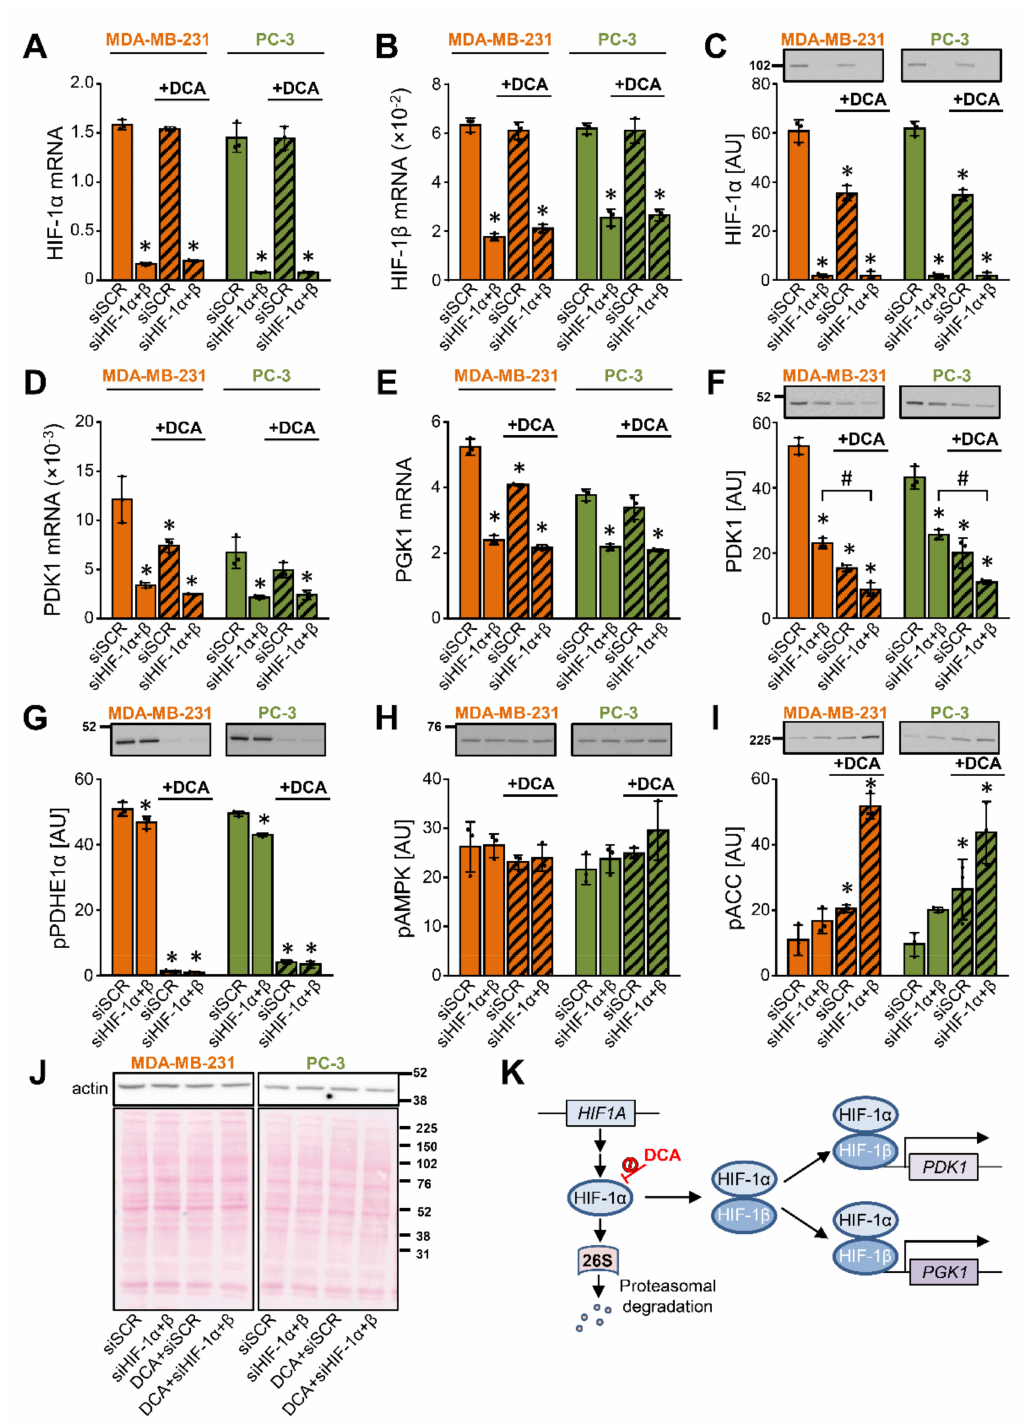
Figure 4. The suppression of PDK1 by DCA is partially independent of the transcriptional control via HIF-1 α . ( A–J ) MDA-MB-231 and PC-3 cells were transfected with siRNAs against HIF-1 α and HIF-1 β to produce a double knock-down (siHIF-1 α + β ). They were subsequently treated with 10 mM DCA for 24 h in serum-free RPMI medium. The mRNA expression of ( A ) HIF-1 α , ( B ) HIF-1 β , ( D ) PDK1, and ( E ) PGK1 was estimated by qPCR (endogenous control: cyclophilin). The protein levels of ( C ) HIF-1 α , ( F ) PDK1, ( G ) phospho-PDHE1 α Ser293 (pPDHE1 α ), ( H ) phospho-AMPK α Thr172 (pAMPK), ( I ) phospho-ACC Ser79 (pACC), and ( J ) β -actin were determined with immunoblotting. ( J ) Protein loading was evaluated by the Ponceau S staining. Numbers next to the blots and Ponceau stains indicate molecular weight markers in kDa. ( K ) Schematic representation of regulation of gene expression by HIF-1. Results are means ± SD of one experiment performed in triplicate for each cell line ( n = 3). * p < 0.05 vs. siSCR and # p < 0.05 as